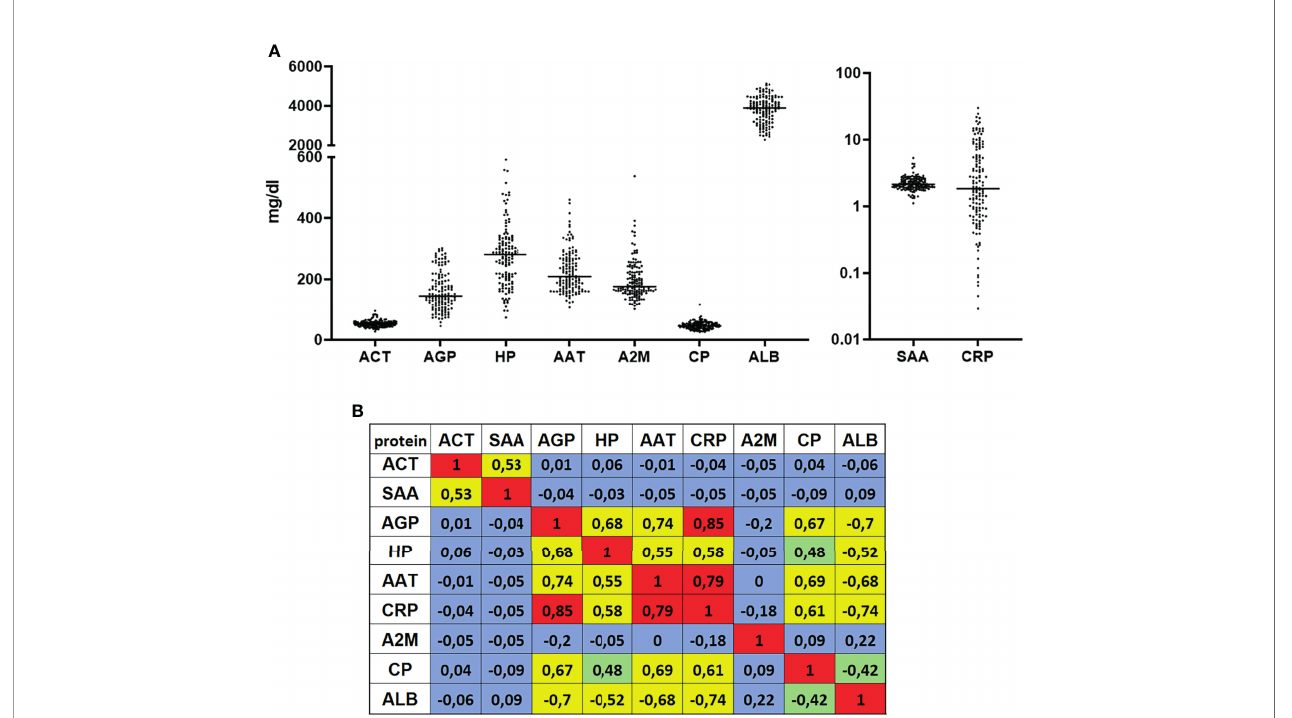
FIGURE 1 | Serum concentrations and correlations of measured acute phase proteins. (A) Nine acute phase proteins were measured in serum of patients with NSCLC (n = 139) prior to a PD-1 or PD-L1 immunotherapy. (B) Spearman ranked correlation analyses of measured serum values. Values with r > 0.5 or r < -0.5 were considered as correlation. Colours indicate- red-strong correlation; yellow- reliable correlation; green-weak correlation; blue-no